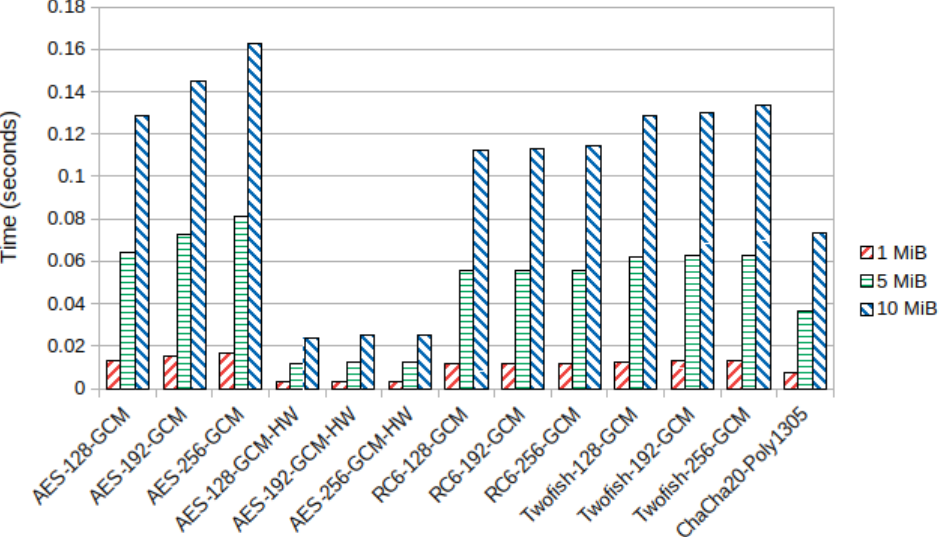
Figure A5. Average decryption time (seconds) in the ARMv8-a Xiaomi device.